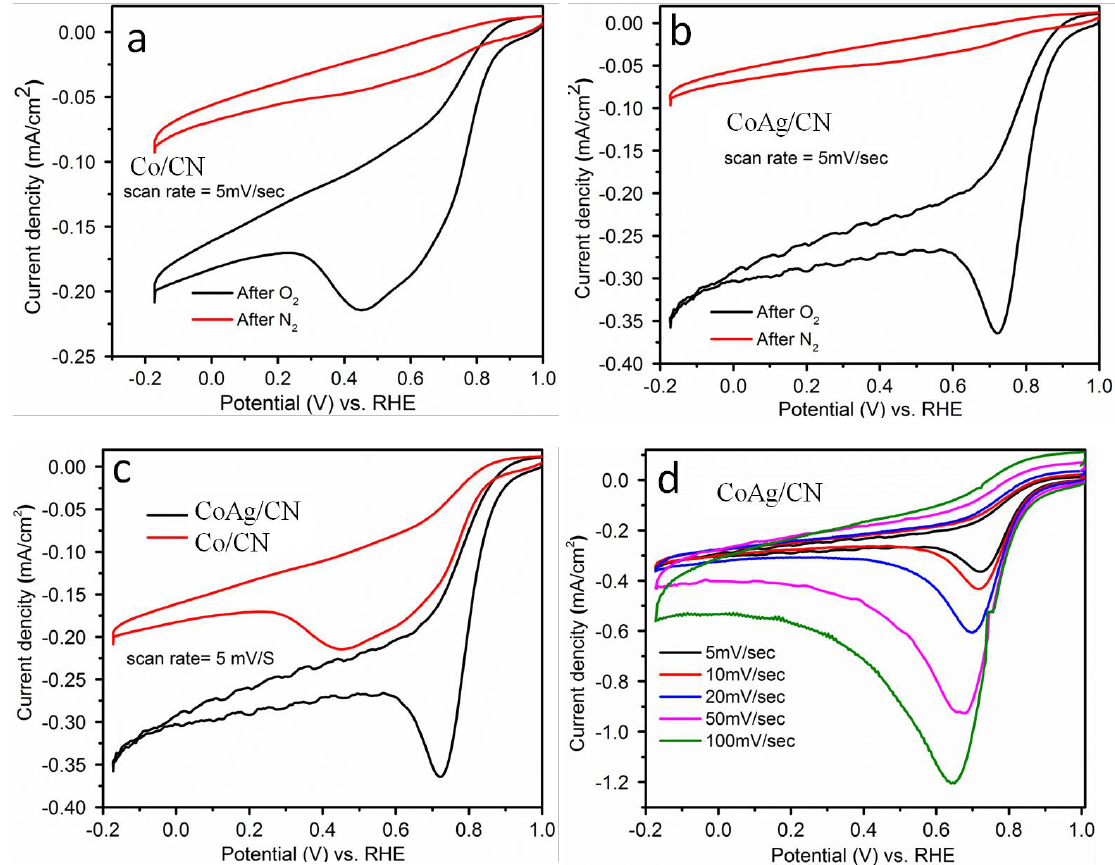
Figure 6. ( a ) Cyclo voltammogram diagram of Co/CN after N 2 and O 2 purge. ( b ) Cyclo voltammogram of CoAg/CN after N 2 and O 2 purge. ( c ) CV comparison of Co/CN and CoAg/CN at scan rate of 5mV/sec ( d ) CV of CoAg/CN at different scan rates .